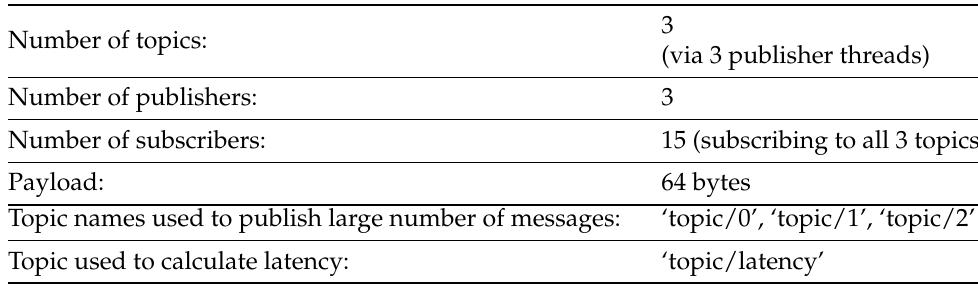
Table 5. Test conditions for the